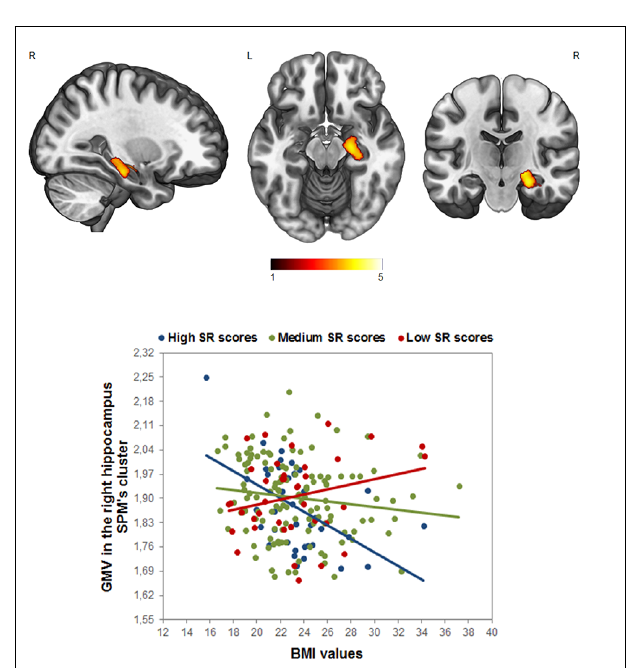
FIGURE 2 | Analyses of the interaction effect between reward sensitivity and BMI in the whole-brain analysis ( p < 0.05, FWE corrected). Bar color represents t -values. (Up) Cluster location in the right hippocampus; (Down) the scatterplot and R 2 is displayed only for visualization purposes. The sample was divided into three groups of high ( > 1 SD), medium ( ± 1 SD), and low ( < 1 SD) Sensitivity to Reward (SR), to visualize the GM modulation based on the SR × BMI interaction in the right